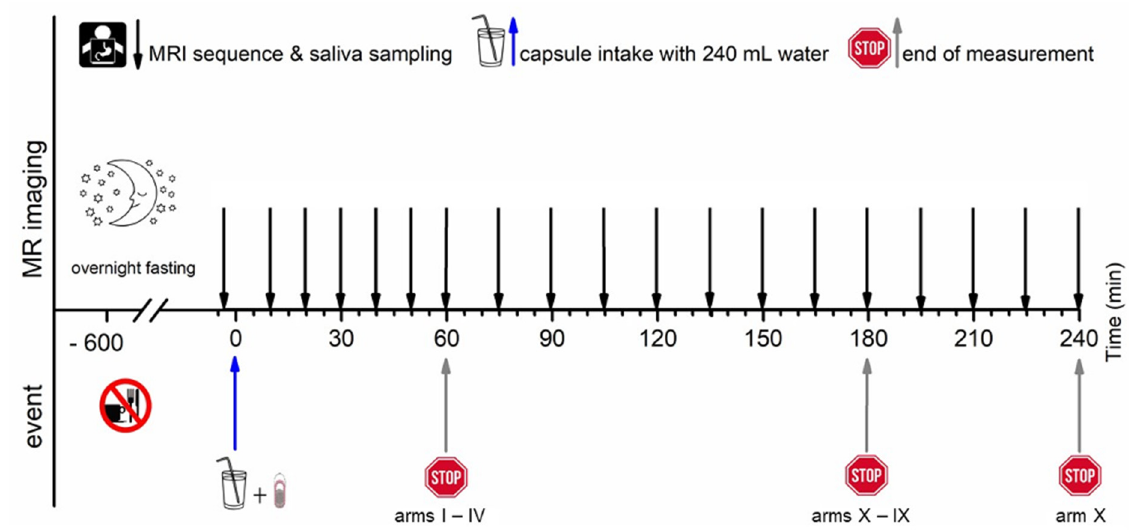
Figure 2. Measurement scheme.